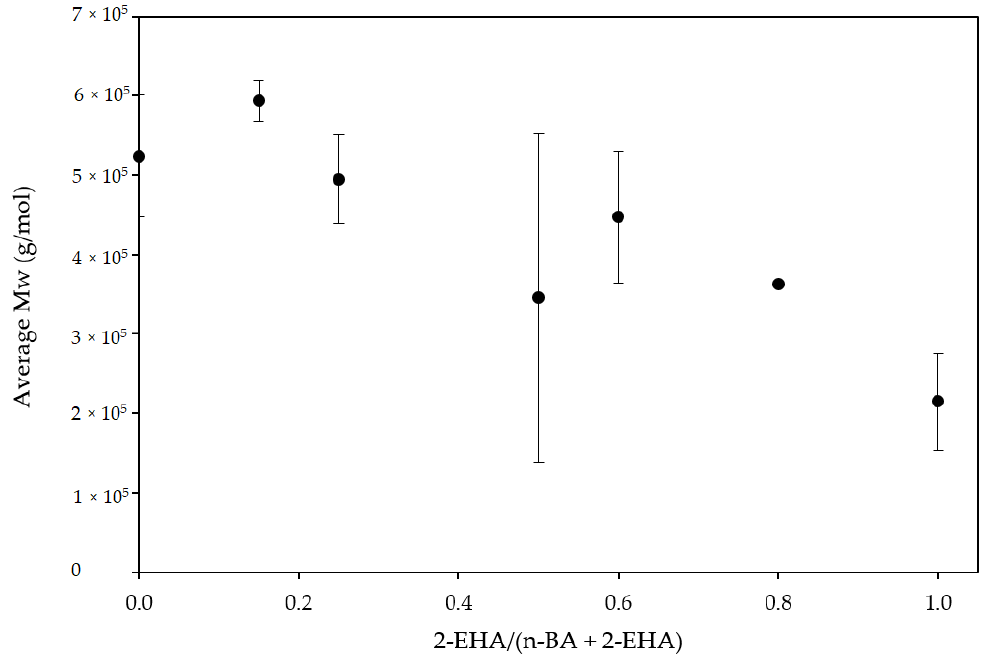
Figure 3. Influence of co-monomer ratio on the average sol molecular weight of the polymers